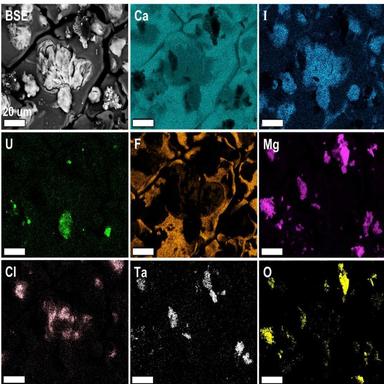
Image and elemental X-ray maps of an area with a Ca/F-rich surface with Ca/I-rich protrusions.